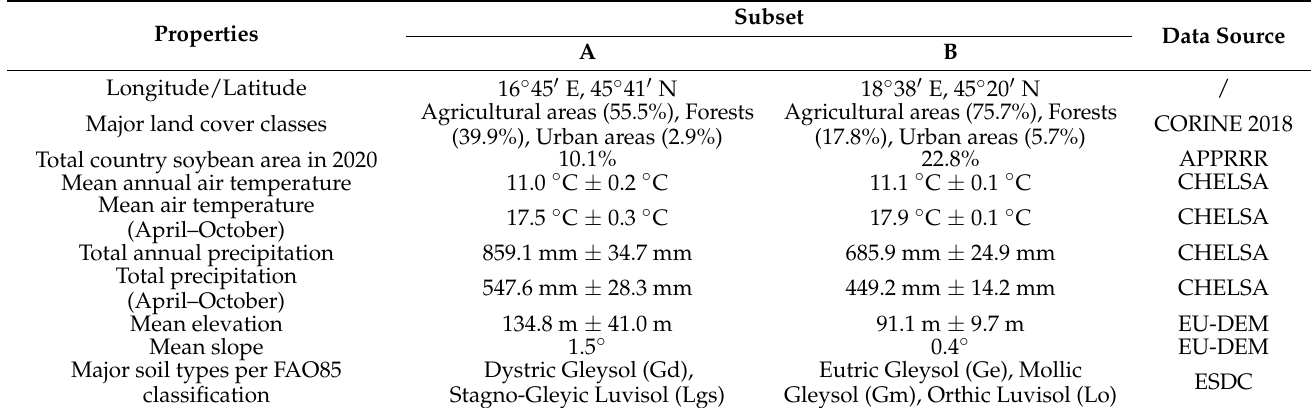
Figure 3. The study area with two 50 × 50 km subsets. Table 1. General properties of subset areas.